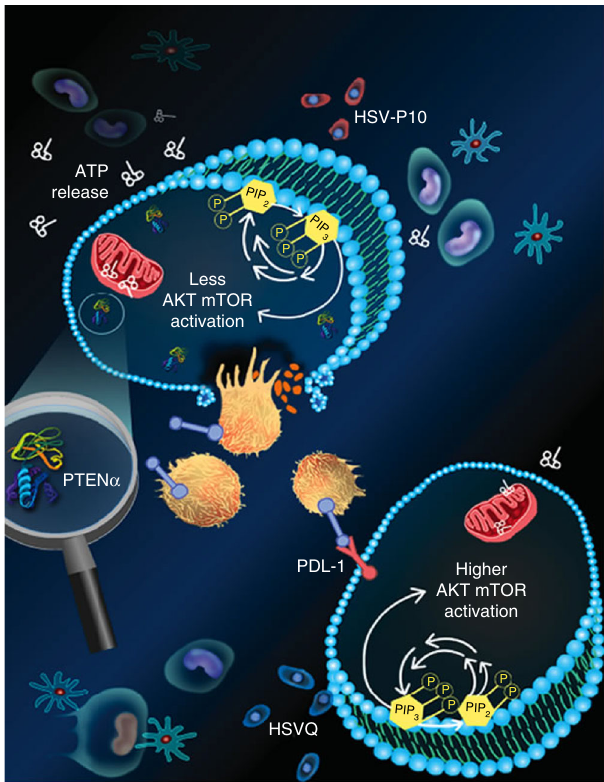
Fig. 10 Schematic representation of HSV-P10 antitumor activity: HSVQ (blue) infection (bottom cell) activates AKT/mTOR signaling, initiating the induction of cell surface PDL-1 that provides an immunosuppressive signal to immune cells in the tumor microenvironment. Upon infection with HSV- P10 (red), PTEN α expression in infected cells reduces the ratio